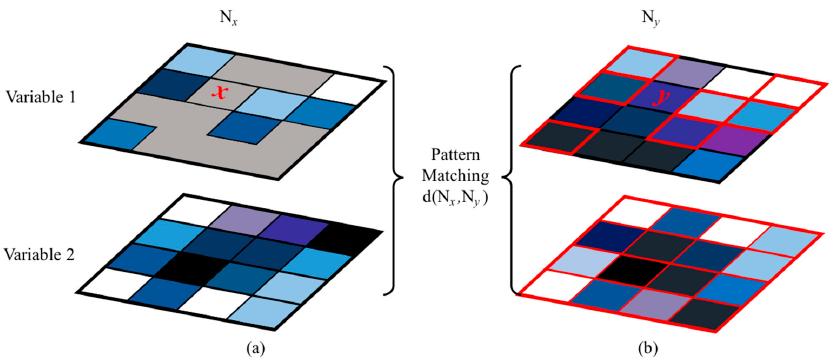
Figure 3. Selection of neighborhood pixels for bivariate simulations, with ( a ) target images and ( b ) training images of the same two variables. Colored pixels are informed, and gray pixels are unknown. The pixel x is the target pixel to be predicted at the current step. Neighborhood pixels of each variable are selected, composing the data event N x . Replicate N y of the data event N x is marked in red in ( b ) and will be used to compute the distance.